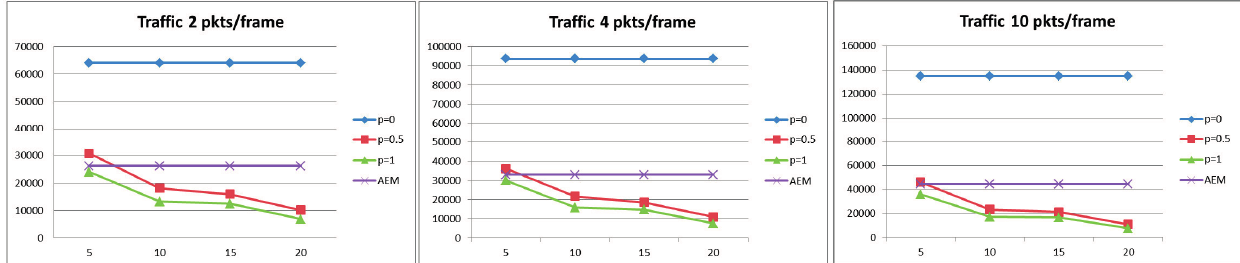
Figure 6. Energy Consumption for D = 40